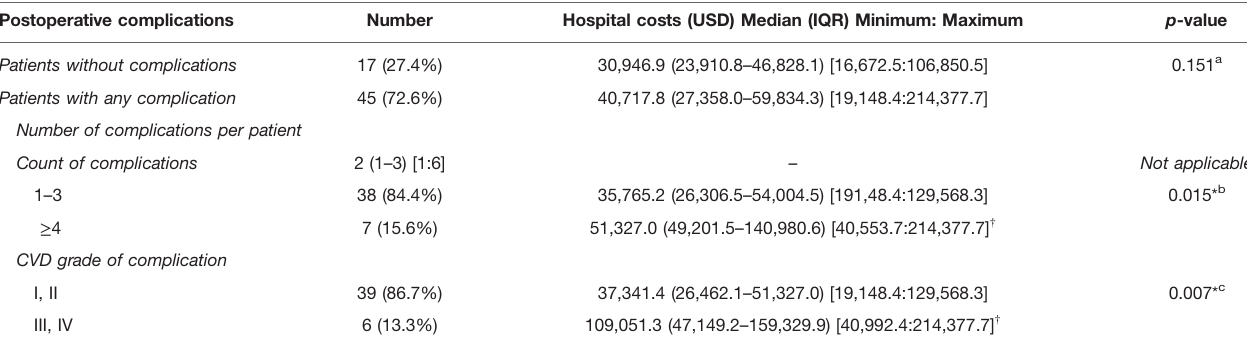
TABLE 2 | Postoperative complications and associated hospital